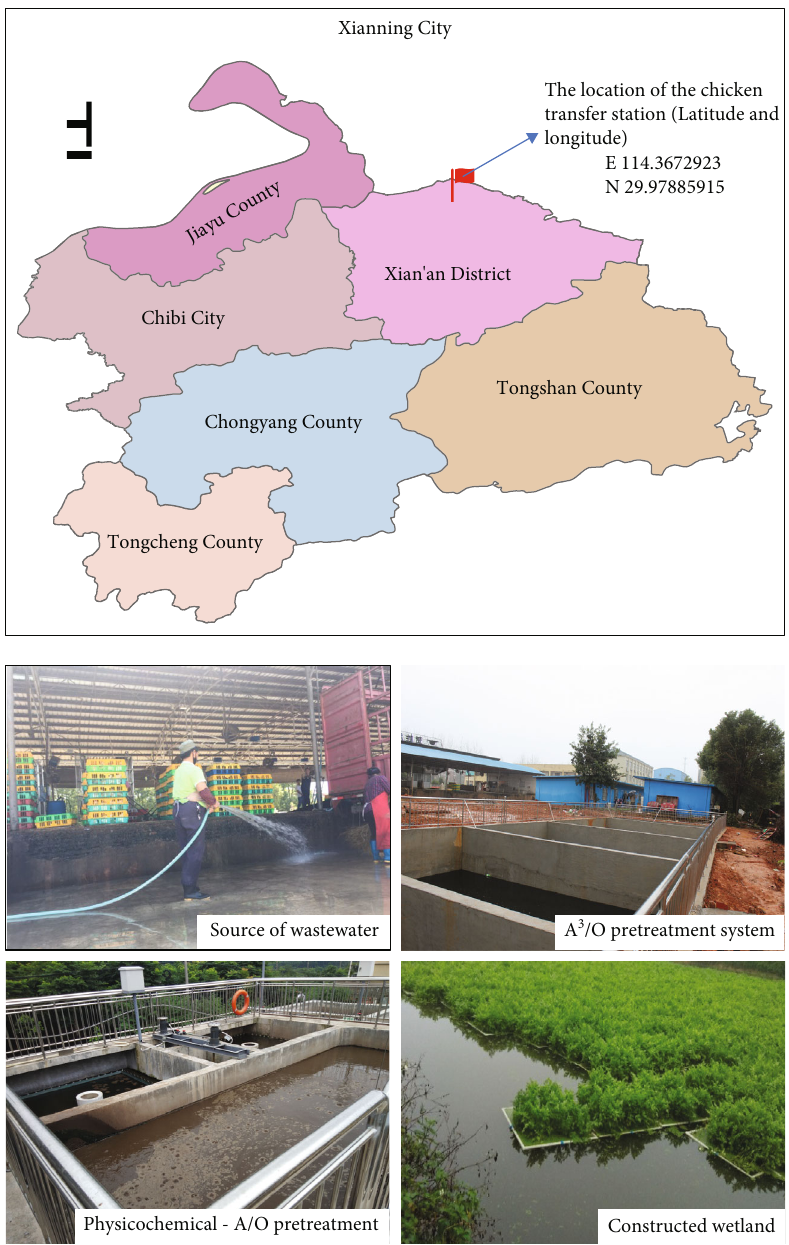
Figure 1: Overview of the research